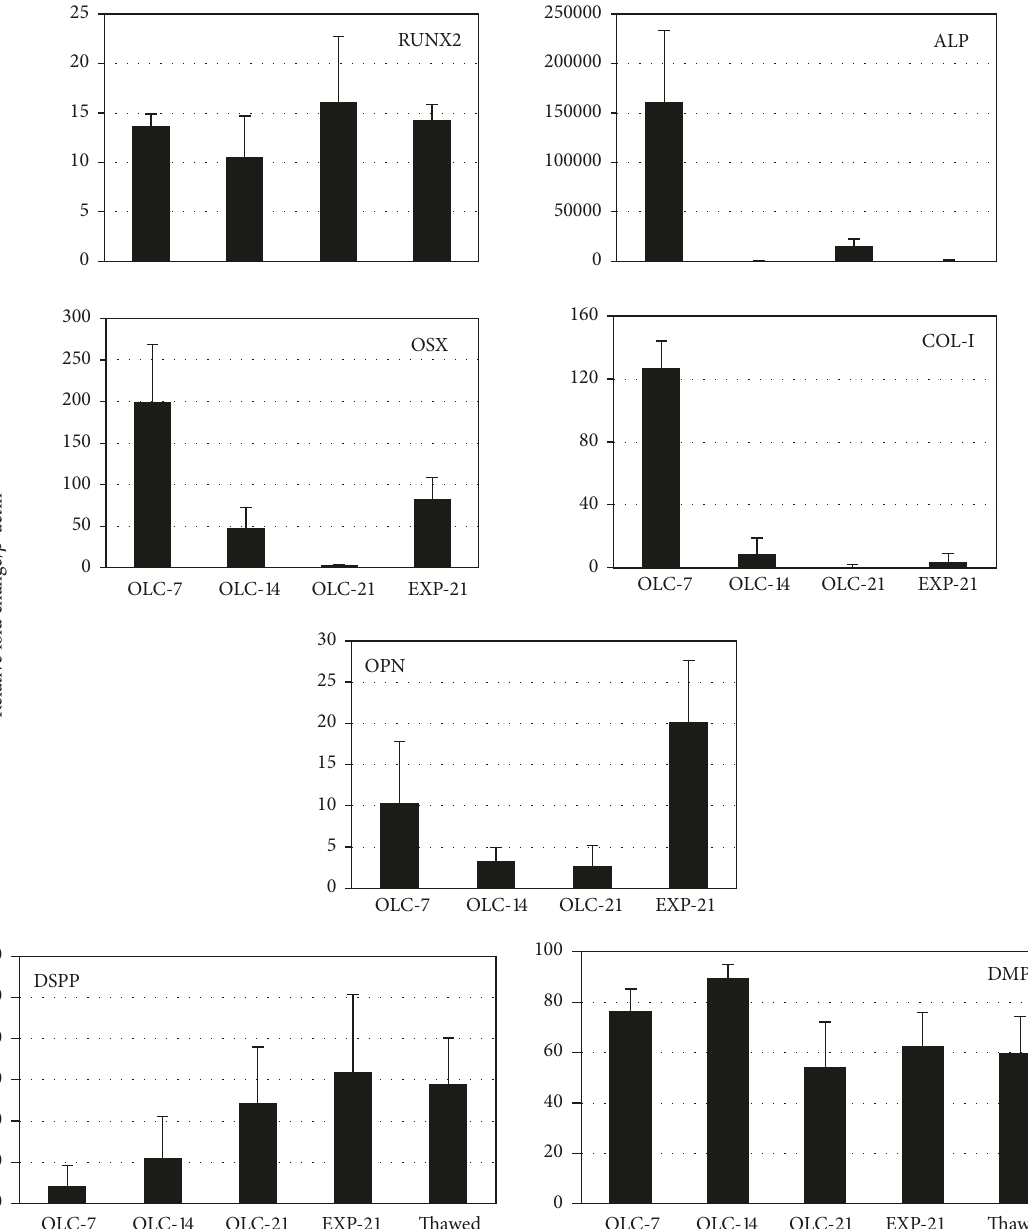
Figure 5: Relative gene expression quantitation during differentiation . Specific odontoblast and mineralizing transcripts were quantitated in differentiating OLC (7, 14, and 21 days) and in both fresh and thawed EXP-21 cells by real-time PCR considering a value of 1 in hDPSC. Data are shown as mean ± SD of three independent experiments in duplicate ( 𝑛 = 6 ). Runt-related transcription factor 2 (RUNX2), alkaline phosphatase (ALP), osterix (OSX), type I-collagen (COL-I), dentin sialophosphoprotein (DSPP), dentin matrix protein-1 (DMP- 1), osteopontin